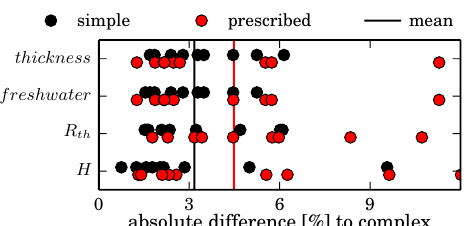
Figure 16. Ratios of the time-integrated ice thickness, freshwater column, thermal resistance R th , and enthalpy H of the simple and the prescribed SAMSIM salinity approach compared to the complex approach (details in Sect. 5). The ratios were calculated separately for each of the nine reanalysis forced simulations over 4.5 years. Each dot shows the ratio of a specific simulation, while the lines show the mean overall runs and quantities.